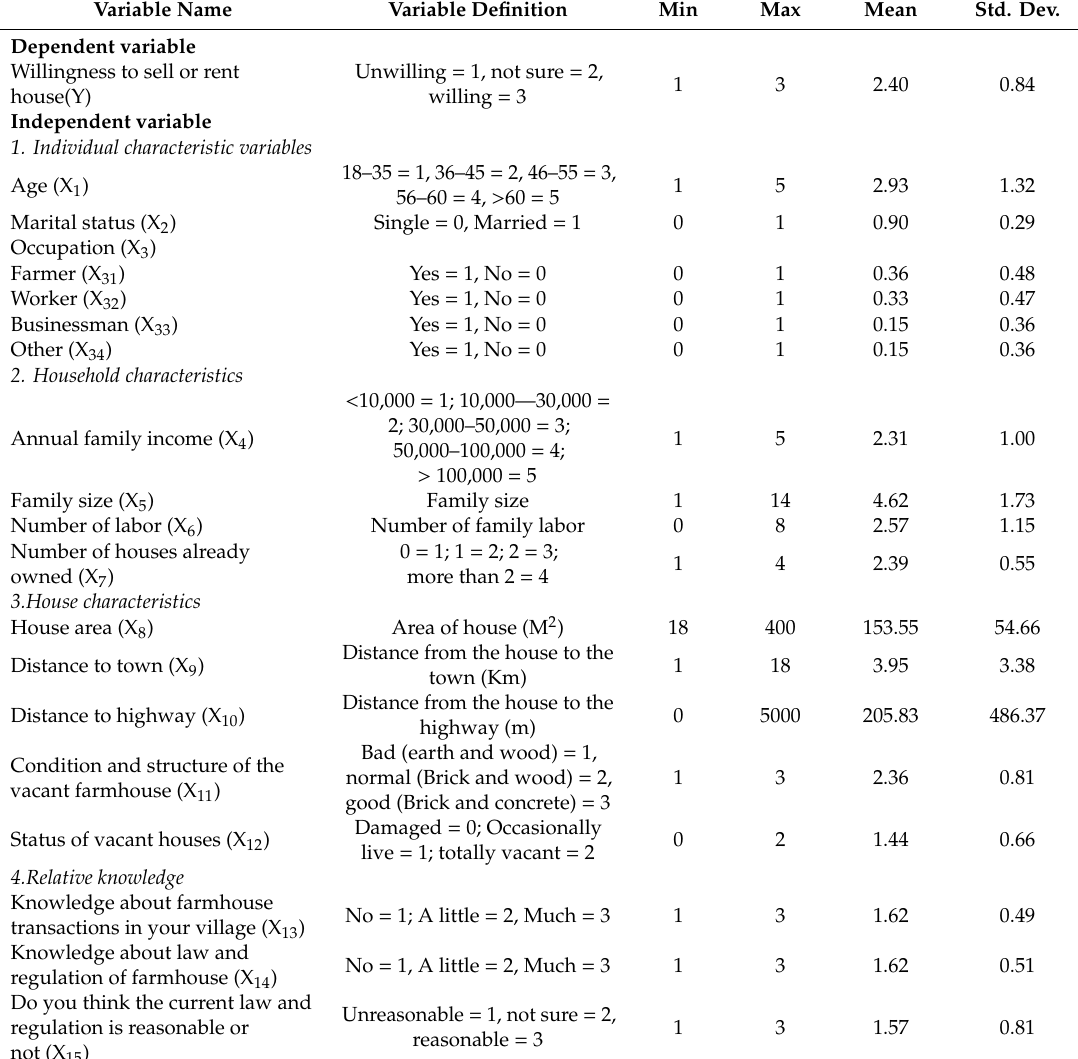
Table A1. Variable description and statistical features of house